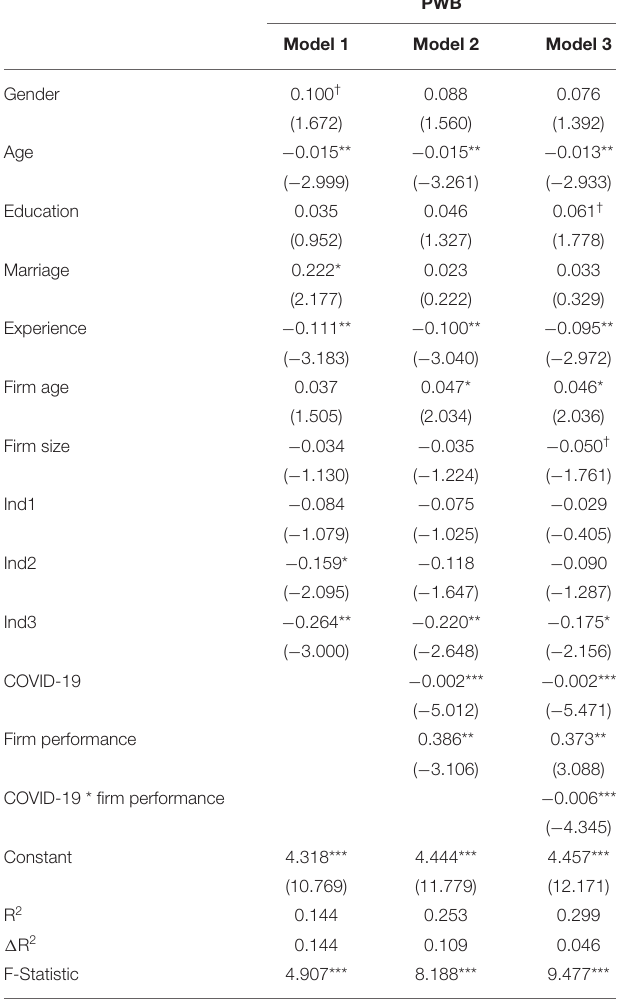
TABLE 3 | Results of regression